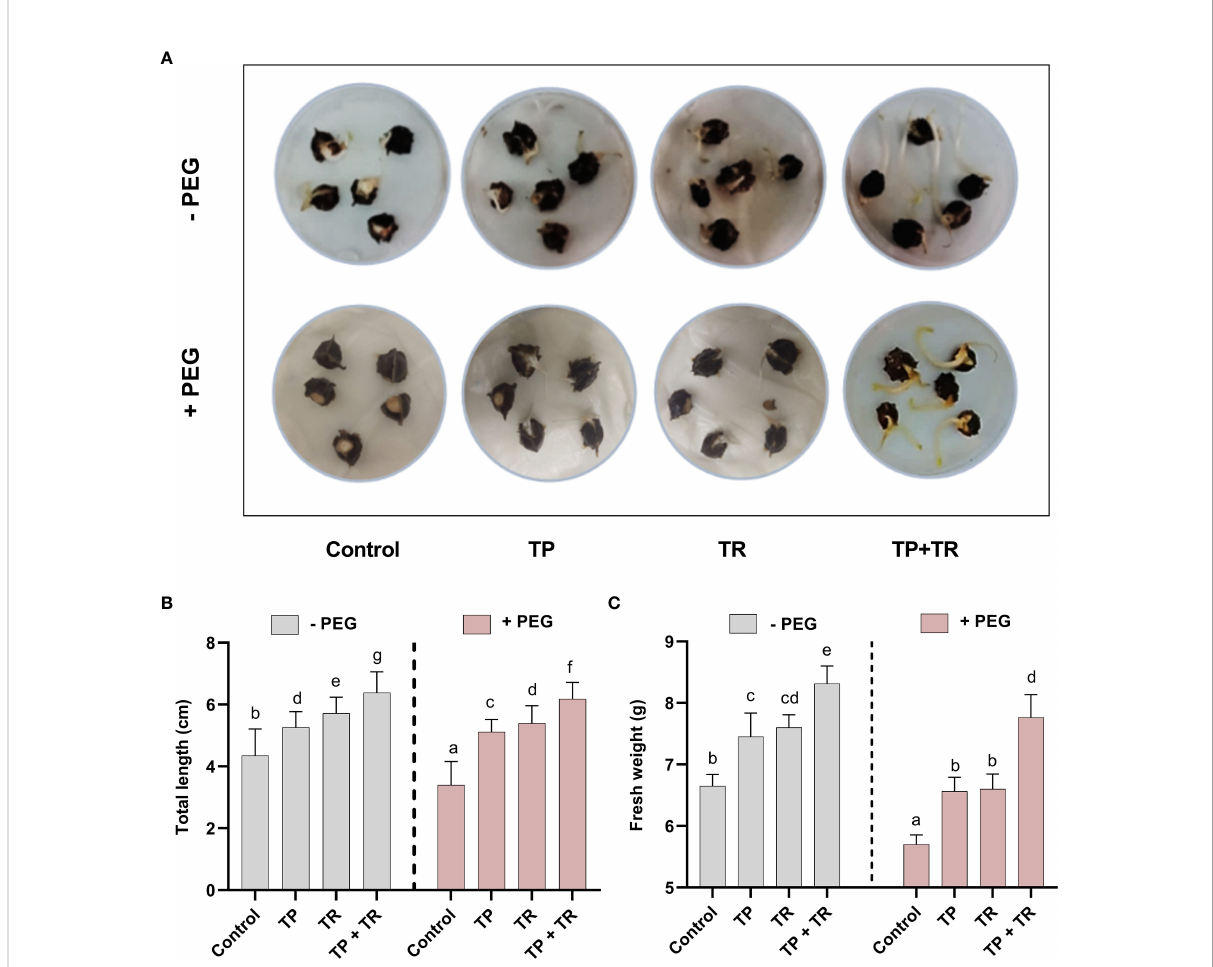
FIGURE 4 Assessment of PEG-mediated drought stress tolerance response of M. oleifera seeds by germination test. (A) Seed germination response under PEG-induced drought conditions in the absence (above penal) and presence (lower penal) of endophytic CF inoculation, (B) cotyledon length and (C) fresh weight. Quantitative data is representing the means ± SE values of at least three independent biological replications. Various letters have been presented to show the statistical differences at signi fi cance level of p¾ 0.05 using Duncan ’ s Multiple Range Test